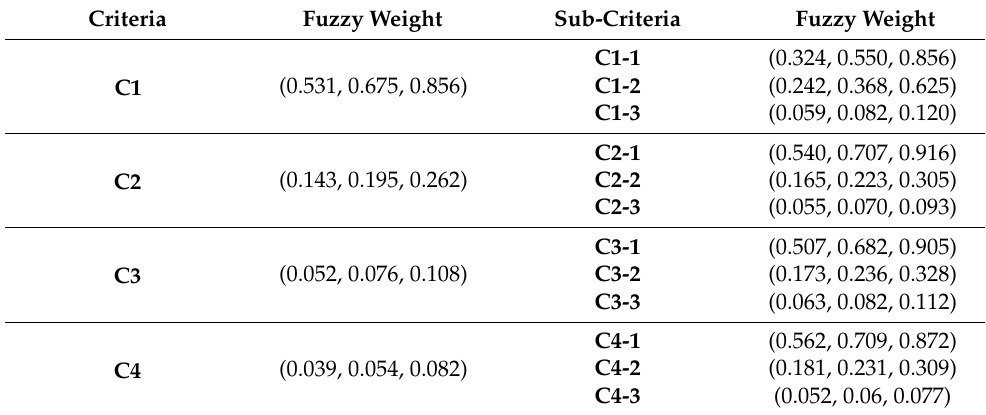
Table 12. Main criteria and sub-criteria fuzzy weight.